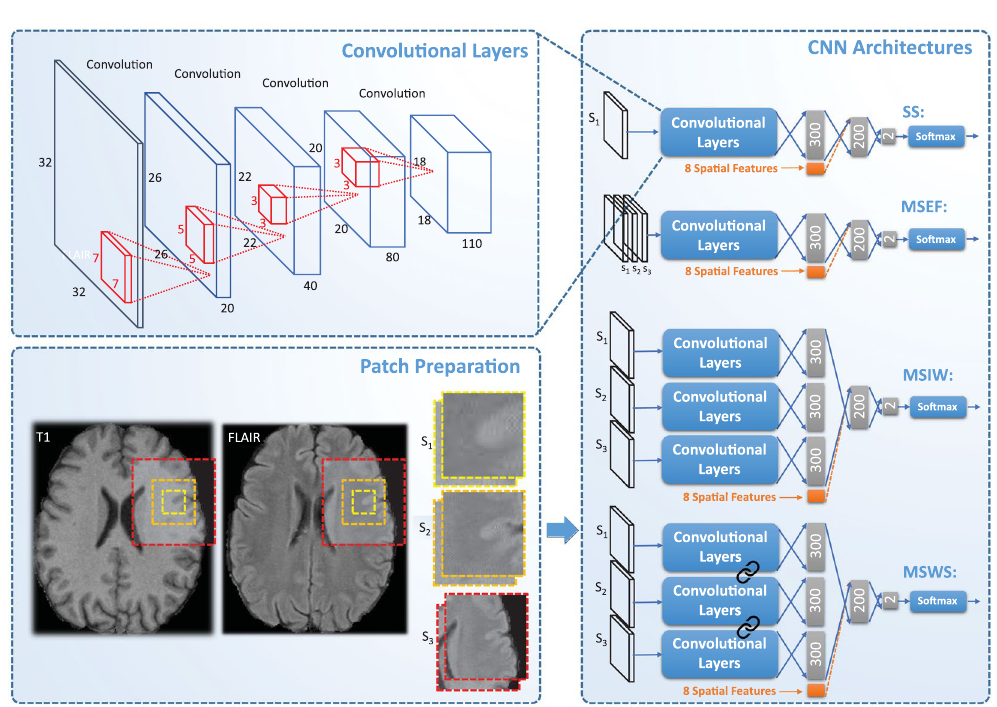
Figure 3. Patch preparation process and different proposed CNN architectures. The links between set of convolutional layers represent a weight sharing policy among the